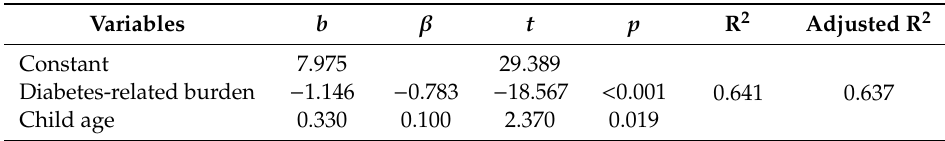
Table 4. Predictors of maternal QOL for children with type 1 diabetes (T1D) in an online health community ( N =